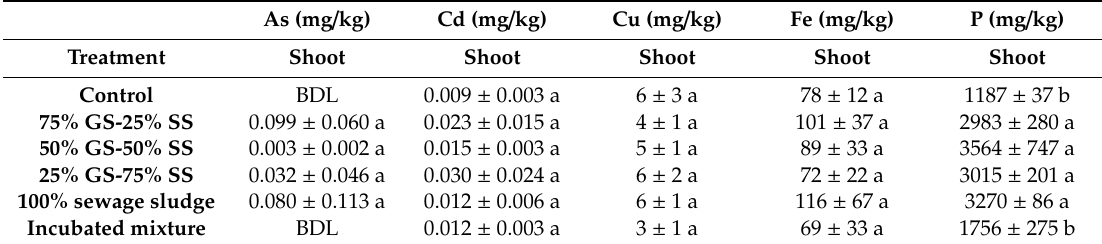
Table 5. Total concentration of elements in the aerial part of corn plants (mg / kg) (averaged value ± standard error; n = 3 or 4). As (mg / kg) Cd (mg / kg) Cu (mg / kg) Fe (mg / kg) P (mg / kg) Treatment Shoot